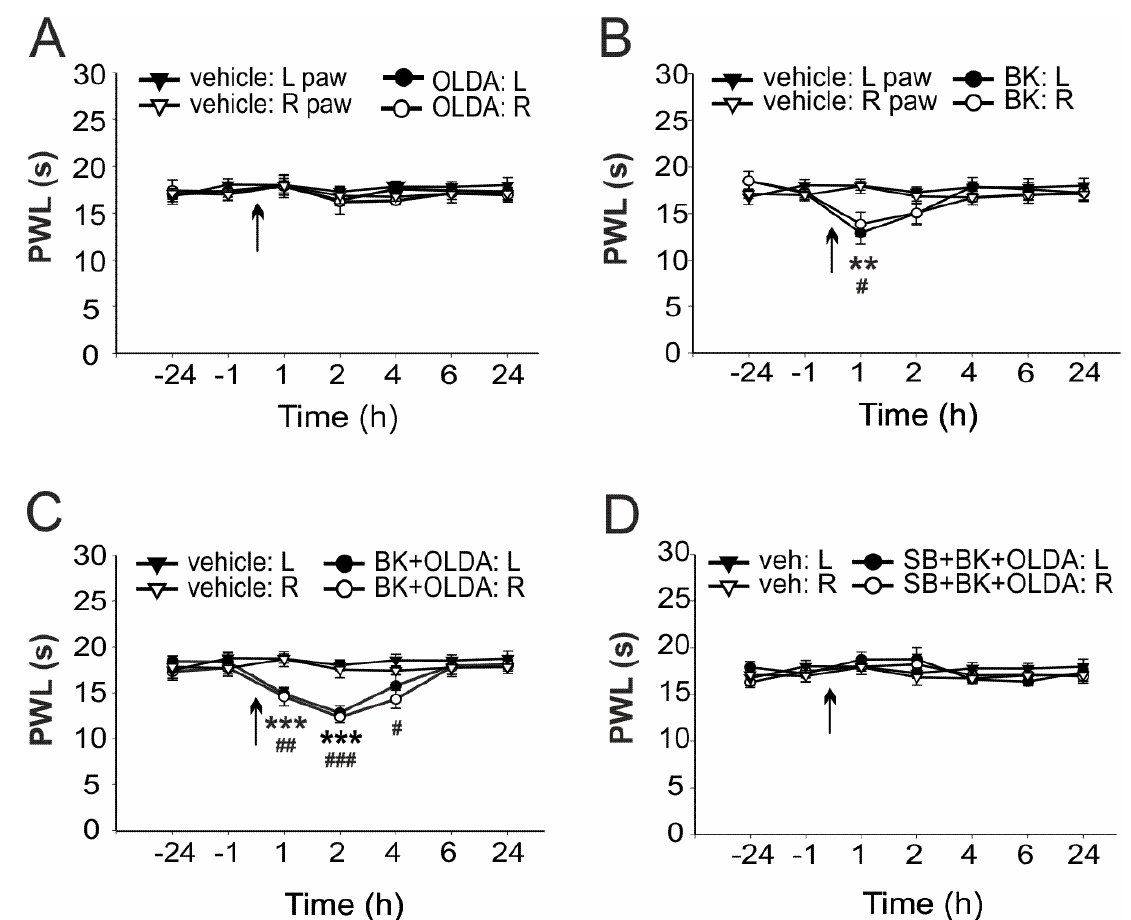
Figure 1. Bradykinin (BK)- and N-oleoyldopamine (OLDA)-induced thermal hyperalgesia was prevented by TRPV1 antagonist pretreatment. ( A ) Intrathecal (i.t.) administration of a relatively low dose of TRPV1 endogenous agonist OLDA (0.42 µg, n = 4) did not change the paw withdrawal latency (PWL), as compared to vehicle-treated rats ( n = 6). ( B ) Administration of BK (21.2 µg, i.t., n = 6) transiently decreased the PWL, as compared to vehicle-treated rats. ( C ) Co-administration of both BK (21.2 µg) and OLDA (0.42 µg, i.t., n = 6) enhanced the hyperalgesic effect induced by BK alone. ( D ) Thermal hyperalgesia induced by BK and OLDA co-administration was prevented by selective TRPV1 antagonist SB366791 pretreatment (SB, 0.58 µg, i.t., 15 min, n = 7). Data represent the mean ± S.E.M. of 4–7 independent experiments. Statistical analysis: Mann-Whitney rank test; ** p < 0.01, *** p < 0.001 left hindpaw (L), BK versus vehicle treatment; # p < 0.05, ## p < 0.01, ### p < 0.001 right hindpaw (R), BK versus vehicle treatment. The time of the i.t. administration is marked by arrows.